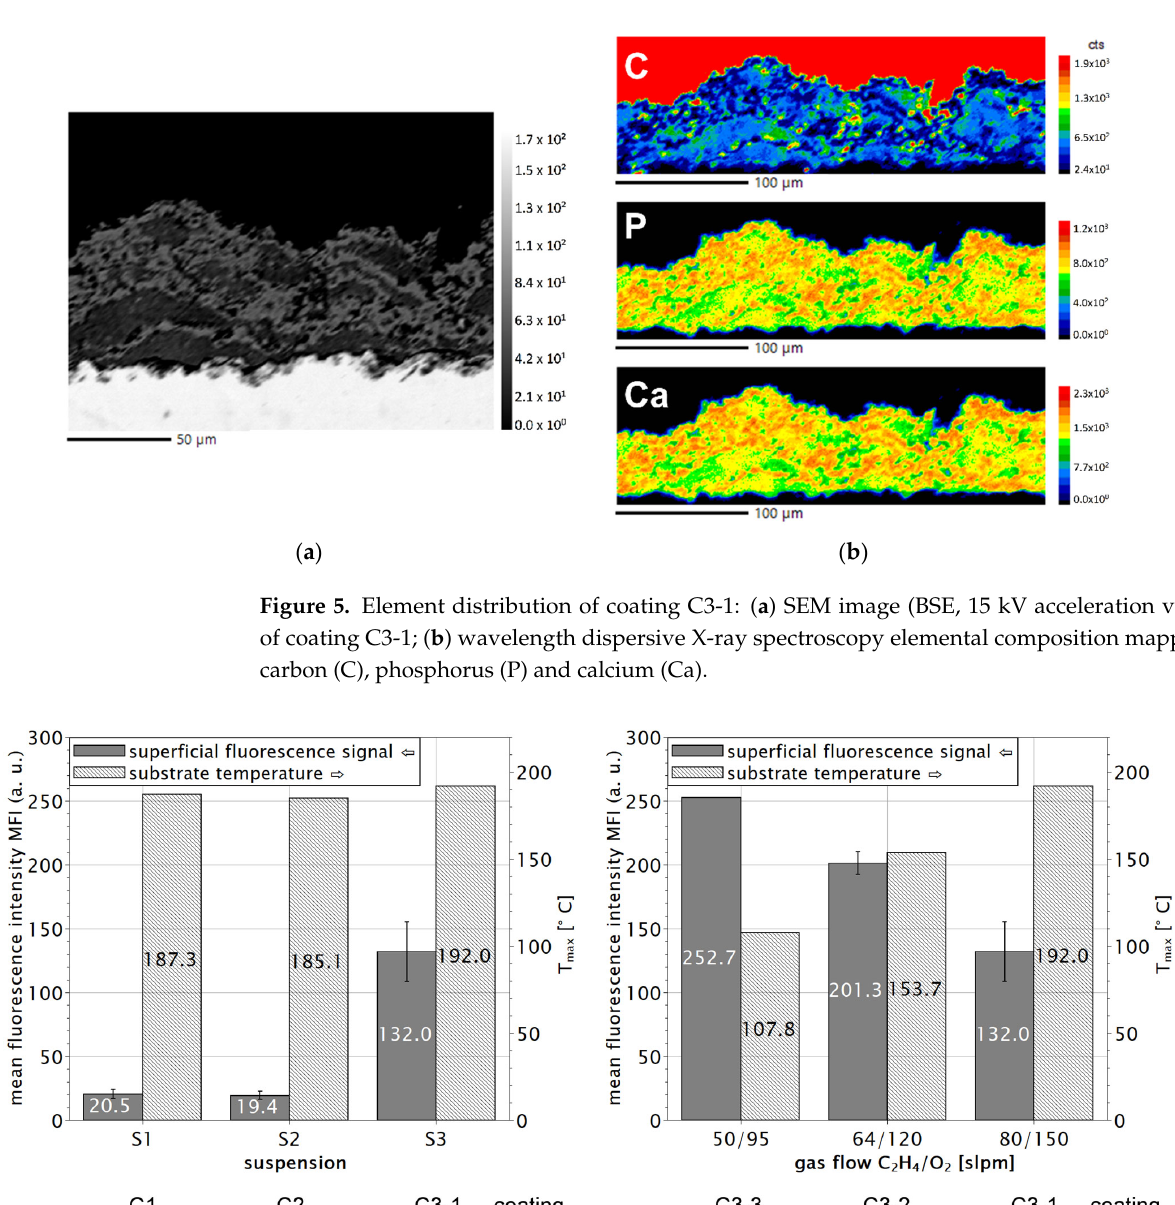
Figure 7. Thermal degradation behaviour of fluoresceine in coating C3 ‐ 3 (suspension S3, gas flow 50/95 slpm) measured as superficial fluorescence intensity (FITC filter set, 100× magnification, 5.6 ms exposure). 4. Discussion 4.1. Suspension Preparation